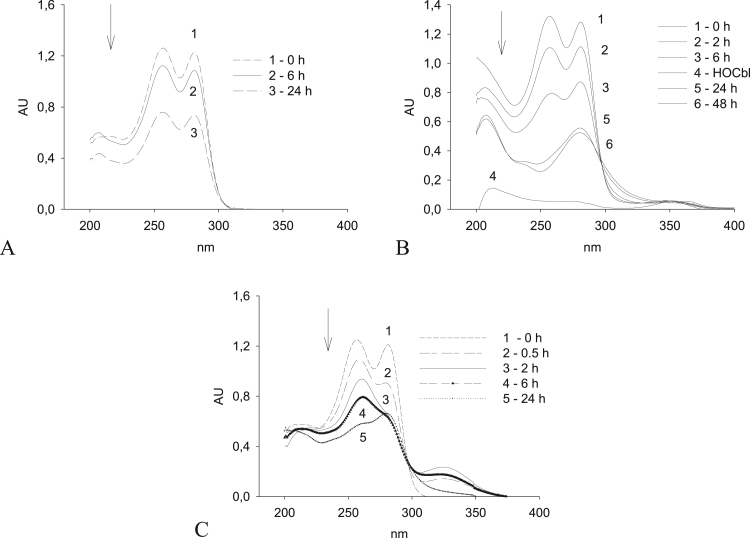
Changes in UV spectra of aqueous solutions of 1 mM DDC (А), 1 mM DDC combined with 25 μM HOCbl (В), 0.1 mM DDC + 0.1 mM Н2О2 (С). (А, В). Before measurements, DDC and DDC + HOCbl solutions were diluted tenfold; only the spectra of unilluminated solutions were recorded.